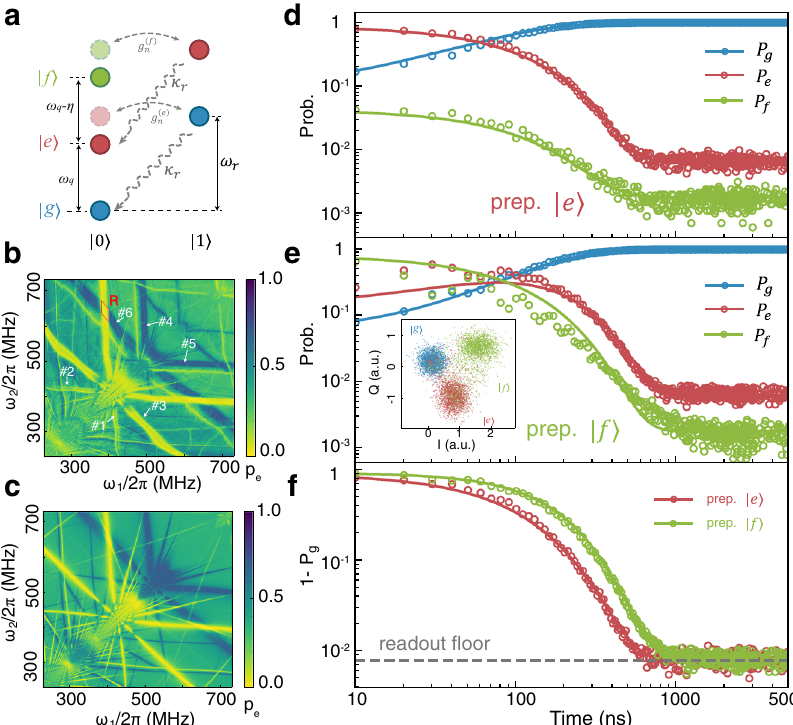
Fig. 4 Two-tone parametric modulation. a Jaynes-Cummings ladder diagram of the two-tone parametric modulation process. g j i , e j i , f j i and 0 j i , 1 j i denote the lowest energy states of the qubit and resonator, respectively. The dashed pale red and green circles represent one of the sideband modes induced by the parametric modulation. The dashed arrow labeled κ r illustrates the decay process of the resonator. b Scan map of the e j i population after 1000 ns two- tone parametric modulation. Before modulation, the qubit was prepared in the f j i state. Blue and yellow strips correspond to the f ; 0 j i decay processes, respectively. c Master equation simulation with experimental parameters from b . Time evolution of each qubit state, with the qubit initially prepared as e j i ( d ) or f j i ( e ), and then reset with two-tone modulation. Inset fi gure in e is the IQ plot of each state. f Time evolution of all remaining excited states (1 − P g ). The gray dashed line is the readout fl